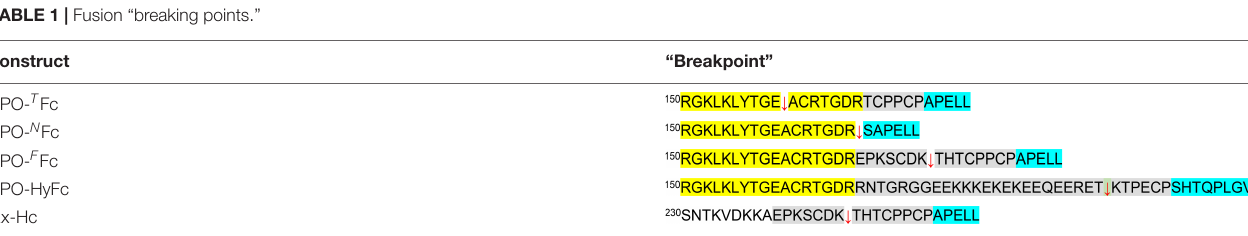
FIGURE 4 | Analysis of the expression of IgG1 fragments. (A) Schematic structures of a monoclonal antibody, a ScFv-Fc and of EPO-Fc. (B) Total soluble protein (TSP) extracts from N. benthamiana (cid:49) XTFT leaves expressing ScFv-Fc and the heavy chain (HC) of IgG1 monoclonal antibodies cetuximab (Cx) and 13F6 were analyzed by immunoblotting with anti- γ chain antibodies (HC of IgG1). Full cetuximab and 13F6 antibodies (HC and LC) were purified out of TSP with protein A and stained with Coomassie Brilliant Blue under reducing conditions (CBB). Western blotting with anti- γ -chain antibodies detects only the HC of the Cx and 13F6 antibodies. Protein size markers are shown in kilo Dalton (kDa). TABLE 1 | Fusion “breaking points.”